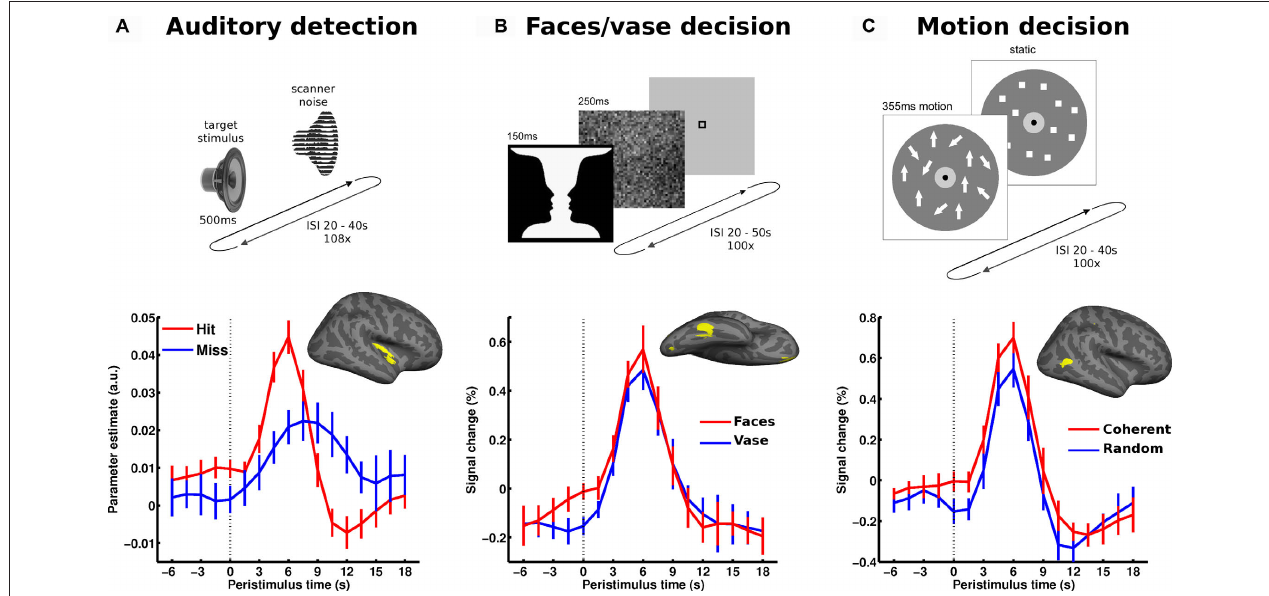
intervals. In each experiment, the pre-stimulus BOLD signal (dotted vertical line marking stimulus onset) was examined as a function of perceptual outcome and sampled from accordingly specialized sensory areas. The corresponding regions of interest (early auditory cortex, FFA and hMT + , respectively) are presented on a canonical inflated cortical surface of the right hemisphere. In all experiments, higher pre-stimulus time course in the respective sensory region biased towards perceiving stimulus properties for which these regions are particularly sensitive. Error bars represent standard error across subjects. For more details see Hesselmann et al. (2008a,b); Sadaghiani et al.